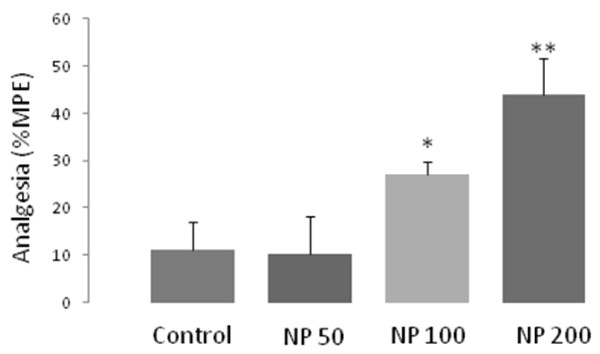
Antinociceptive effects of different doses (i.p.) of the essential oil of Nepeta pogonosperma (NP) on tail flick latency. Comparison was done on percentage of maximum possible effect (%MPE). Each bar represents the mean ± S.E.M. of 6 rats. * = p <0.05, ** = p <0.01 compared to control.